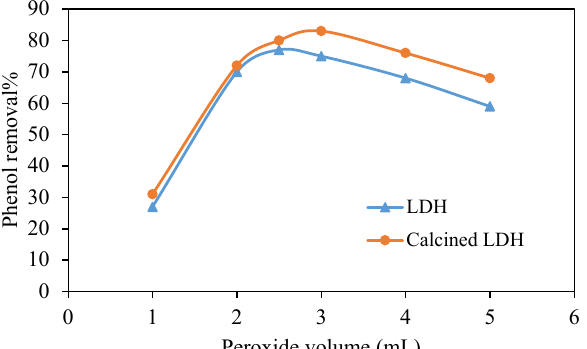
Fig.7. The effect of peroxide volume on phenol removal % over Mg-Al LDH and calcined LDH (reaction conditions: V = 100 mL, m = 0.05 g, initial phenol concentration: 100 mg L -1 , reaction time = 45 min, temperature = 60